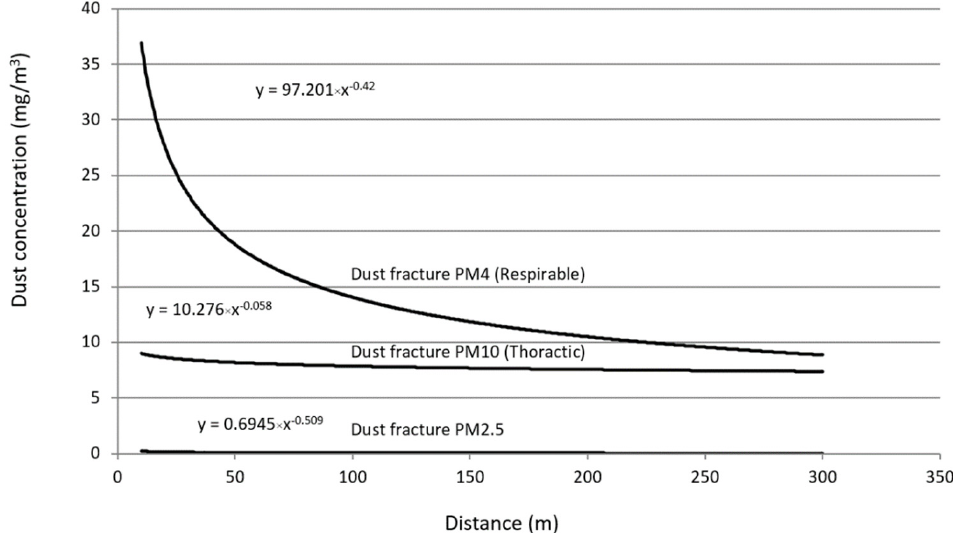
Figure 25. Characteristics and equations of PM10, PM4, and PM2.5 dust concentration for a gate, depending on the distance from the dust source, developed on the basis of in situ tests. The developed equivalent characteristics show each dust fraction distribution depend- ing on a distance from a dust source and type of mine